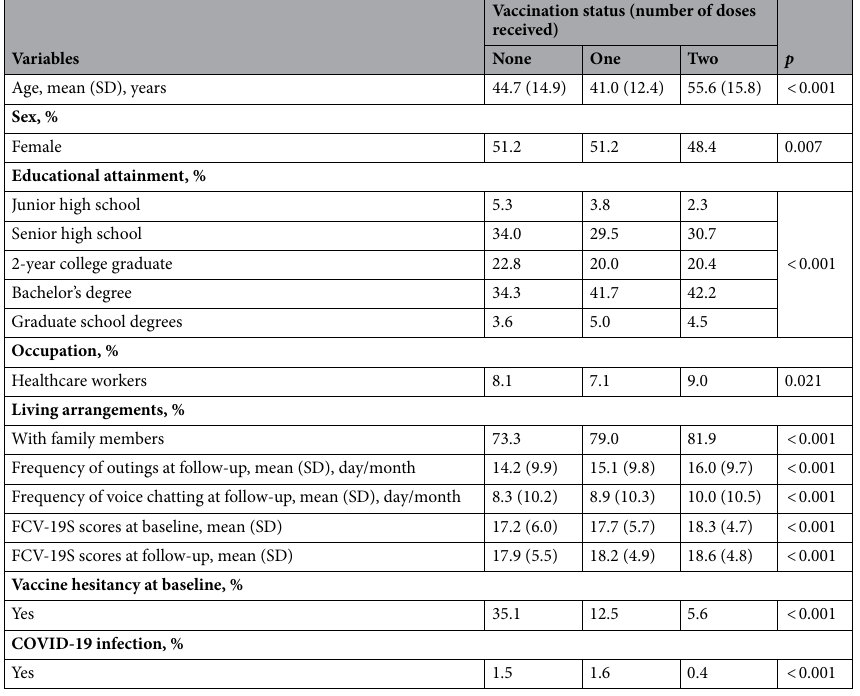
Table 1. Characteristics of participants according to COVID-19 vaccination status, 2021, JACSIS, Japan (n = 17,089). COVID-19 coronavirus disease 2019, SD standard deviation, FCV-19S fear of COVID-19